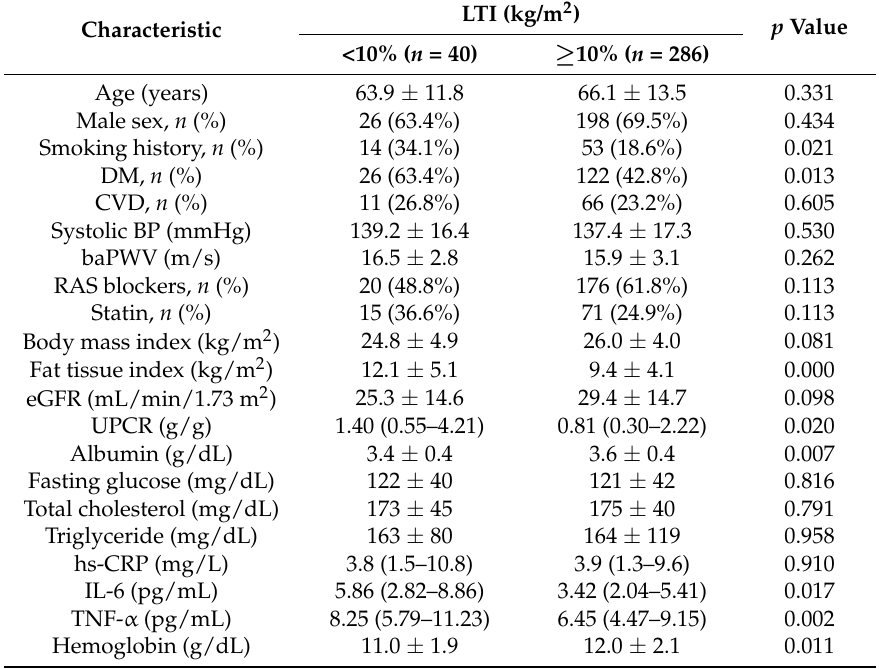
Table 1. Characteristics of CKD patients categorized according to low or normal LTI. Abbreviations: baPWV, brachial-ankle pulse wave velocity; BP, blood pressure; CKD, chronic kidney disease; CVD, cardiovascular disease; DM, diabetes mellitus; eGFR, estimated glomerular filtration rate; hs-CRP, high-sensitivity C-reactive protein; IL-6, interleukin-6; LTI, lean tissue index; RAS, renin-angiotensin